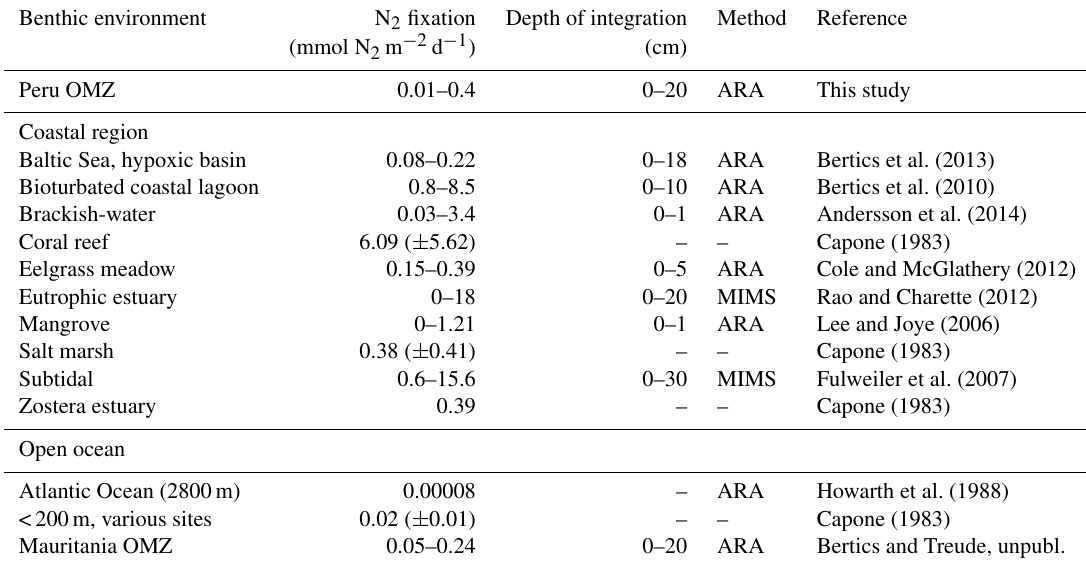
Table 2. Integrated rates of benthic N 2 fixation (mmolN 2 m − 2 d 1 ) in the Peruvian OMZ sediments from this study compared to other marine benthic environments. Only the highest and lowest integrated rates are shown, as well as the integrated sediment depth (cm) and the method used (ARA = acetylene reduction assay, MIMS = membrane inlet mass